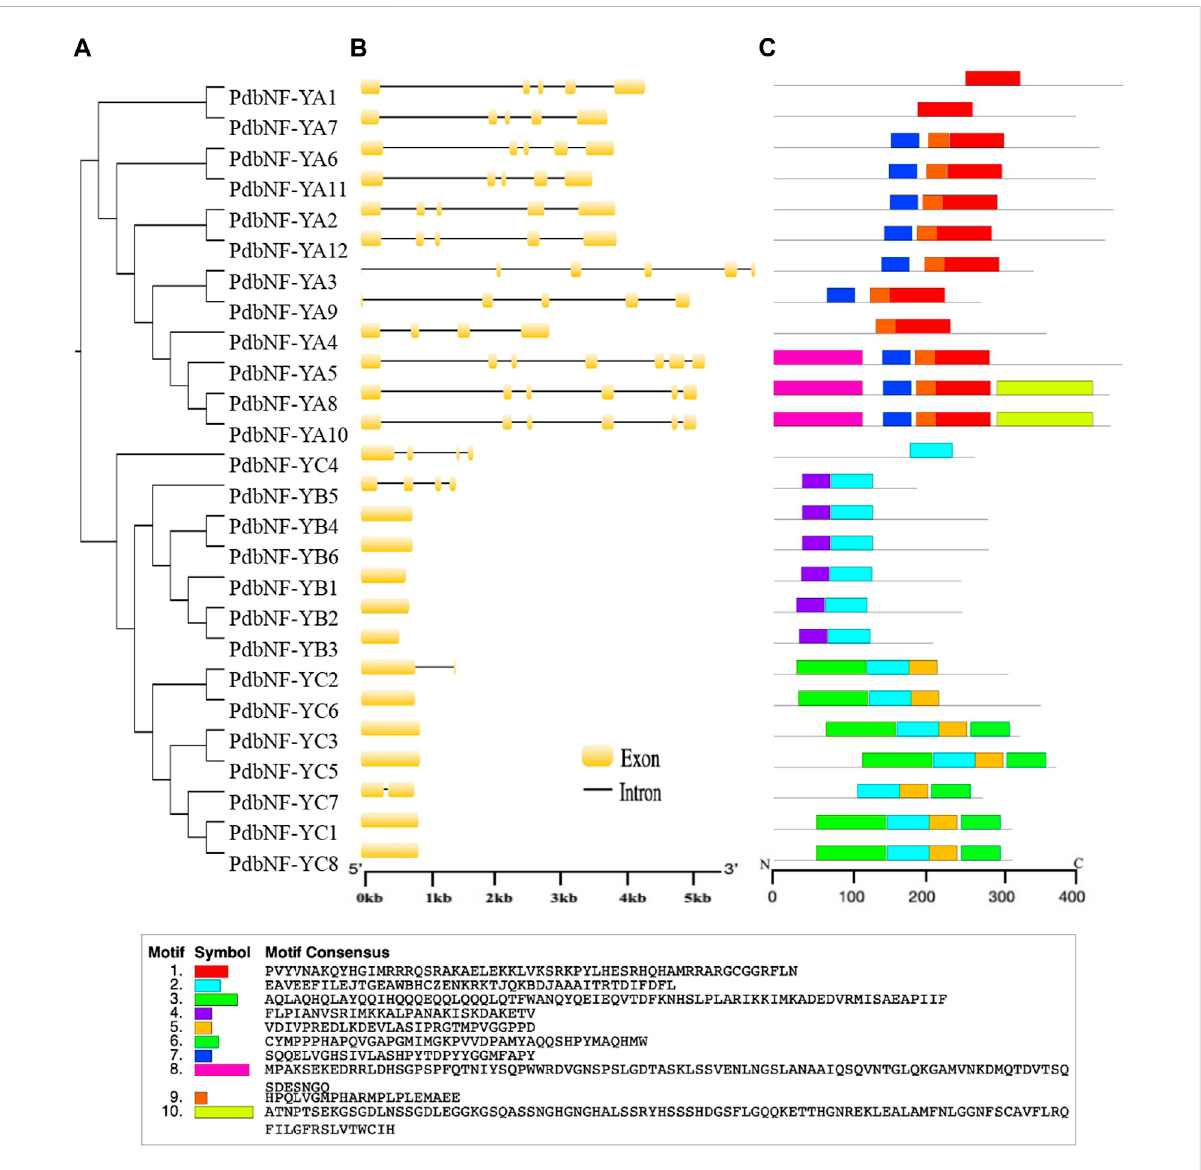
FIGURE 3 Phylogenetic relationships, gene structures,and motif compositions ofthe PdbNF-Y genes. (A) UnrootedNJtree. (B) Exon/intronorganization. Exons are shown as yellow boxes, and introns are shown as black lines. (C) Schematic representation of conserved MEME motifs of full-length NF-Y proteins. Colored boxes indicate different conserved motifs, while the black lines represent sequences with no MEME motifs